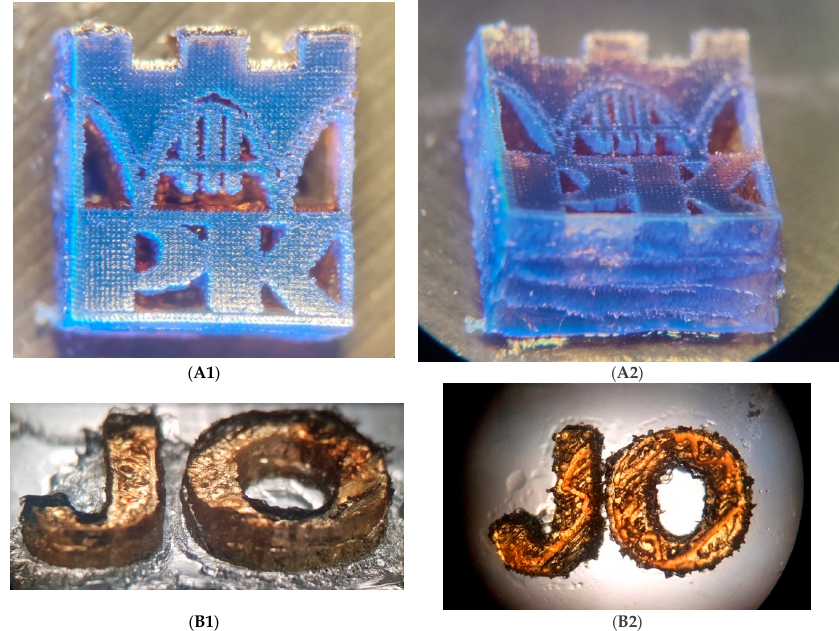
Figure 21. Micrography of ( A ) logo of Cracow University of Technology. The print was obtained from purely cationic photosensitive formulations based on vinyl monomer (TEGDVE) with S8/HIP (0.5%/1.0% w / w ) photoinitiating system. ( A1 ) View from the top under a UV-LED source of light with a maximum emission at 365nm; ( A2 ) side view at 45 o under a UV-LED source of light with a maximum emission at 365nm. ( B ) Object showing the initials “JO”; ( B1 ) print obtained from purely cationic photosensitive formulations based on cycloaliphatic epoxide monomer (CADE) with an initiating system consisting of a double layer print from the formulation of CADE monomer with S8/HIP (1%/1% w / w ), mono-layer height 1 mm; ( B2 ) top view of 3D print.